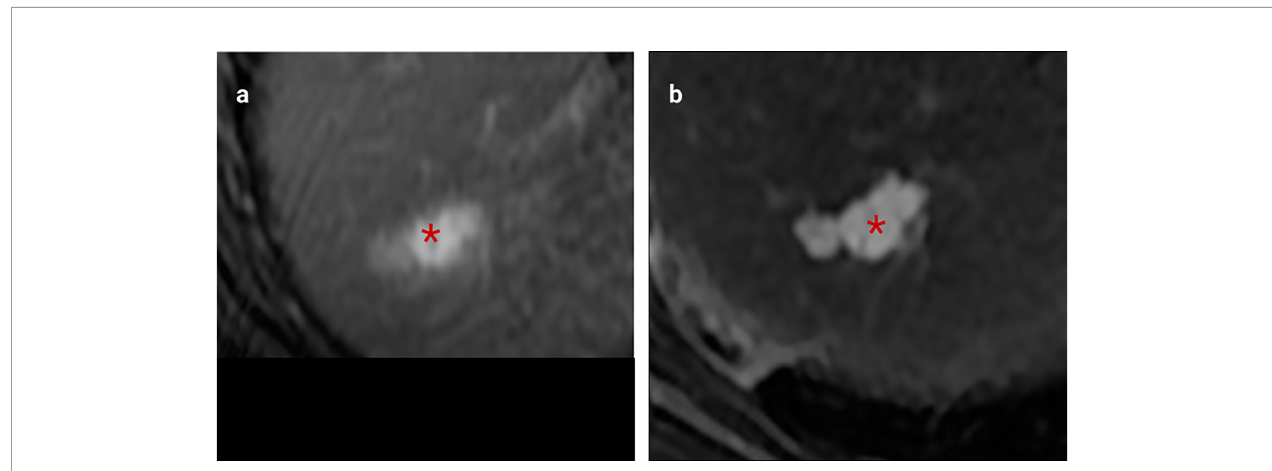
FIGURE 5 | Example of excellent morphological response post-chemotherapy. Both images were obtained using the same MRI scanner performed at 1.5T (GE HDX Twinspeed MR scanner; GE, Milkwaukee, WI) with an 8-channel torso coil. (A) T2 weighted MRI showing a poorly de fi ned CRLM with high T2 region of mucin (asterisk). (B) . Following neoadjuvant treatment, this lesion demonstrates no change in size but now has a well-de fi ned margin and replacement of intermediate signal cellular tumour with mucin, indicative of a good morphological response (asterisk). There was a complete pathological response at